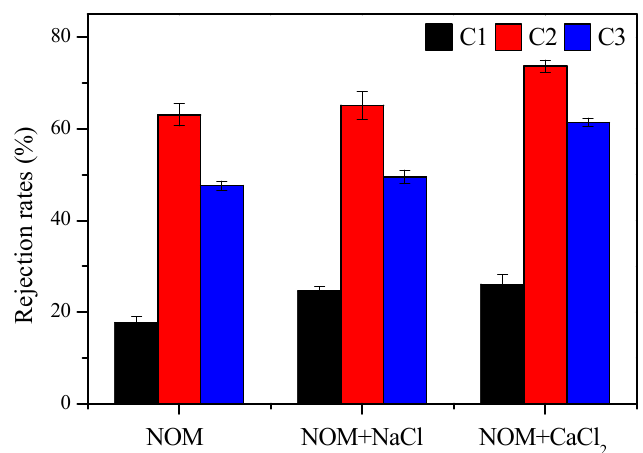
Figure 5. Performance of fluorescent component rejection during reconstituted NOM solution treatment using UF. Error bars indicate the standard error of triplicate measurements.